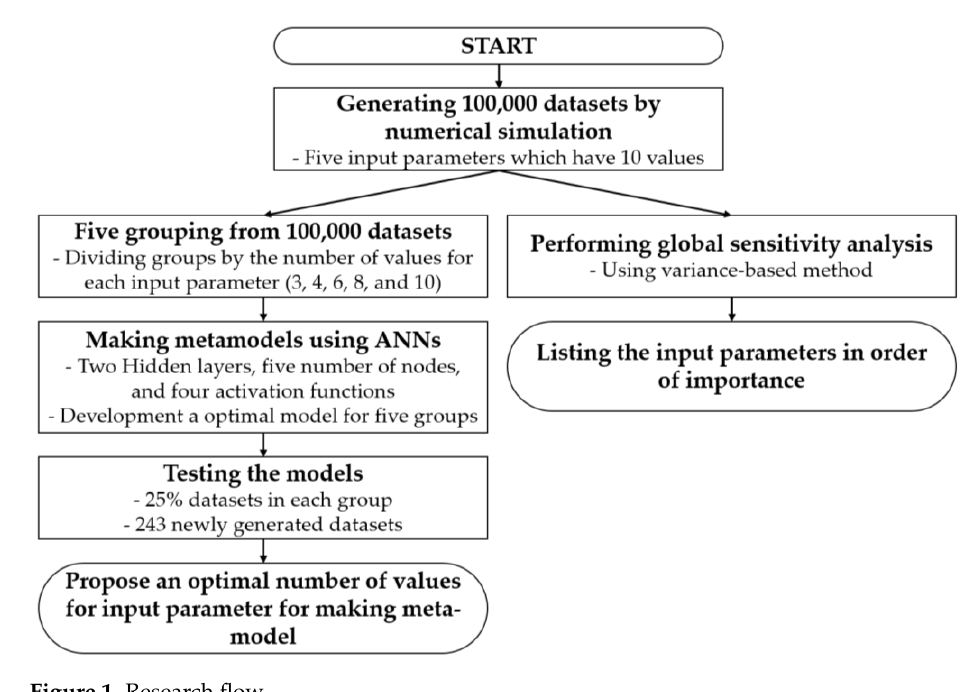
Figure 1. Research flow.